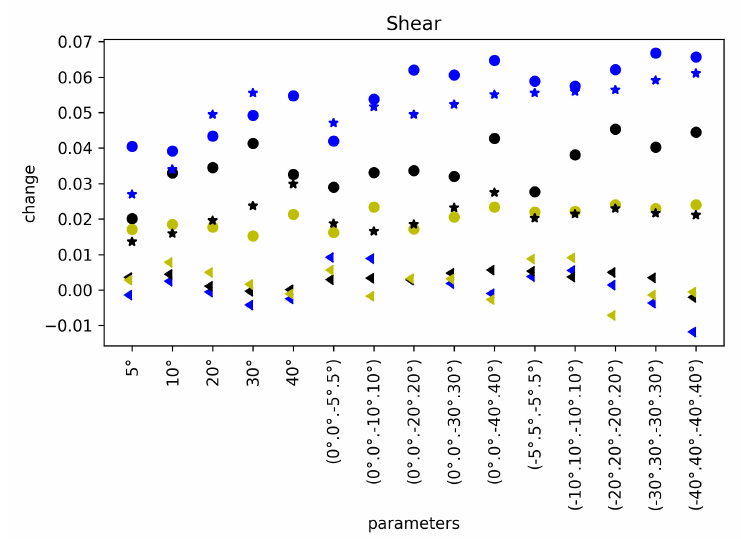
Figure 7. Impacts comparison of Rotation and Shear. The figure reveals the impacts of the different parameters of Rotation and Shear on Γ PAP , Γ CCZ , and Γ CSD classification performance improvement.